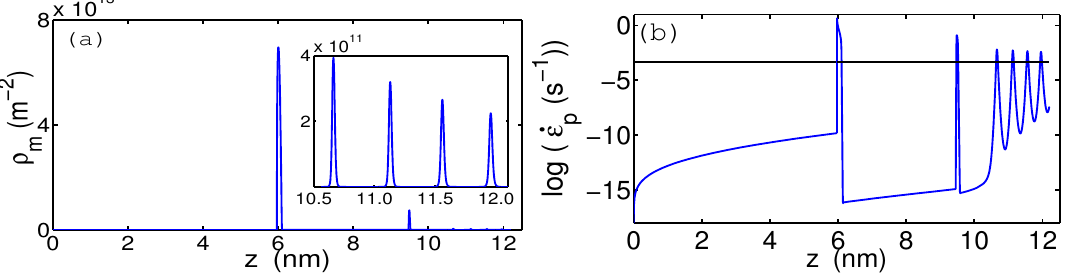
Figure 5. ( a ) Plot of ρ m verses z . Inset in ( a ) shows bursts of ρ m beyond the second; ( b ) plot of log(˙ (cid:101) p ) as a function of z . Continuous line corresponds to ˙ r / T = 4.65 × 10 − 4 s − 1 . Parameters used are given in the Table 1, after